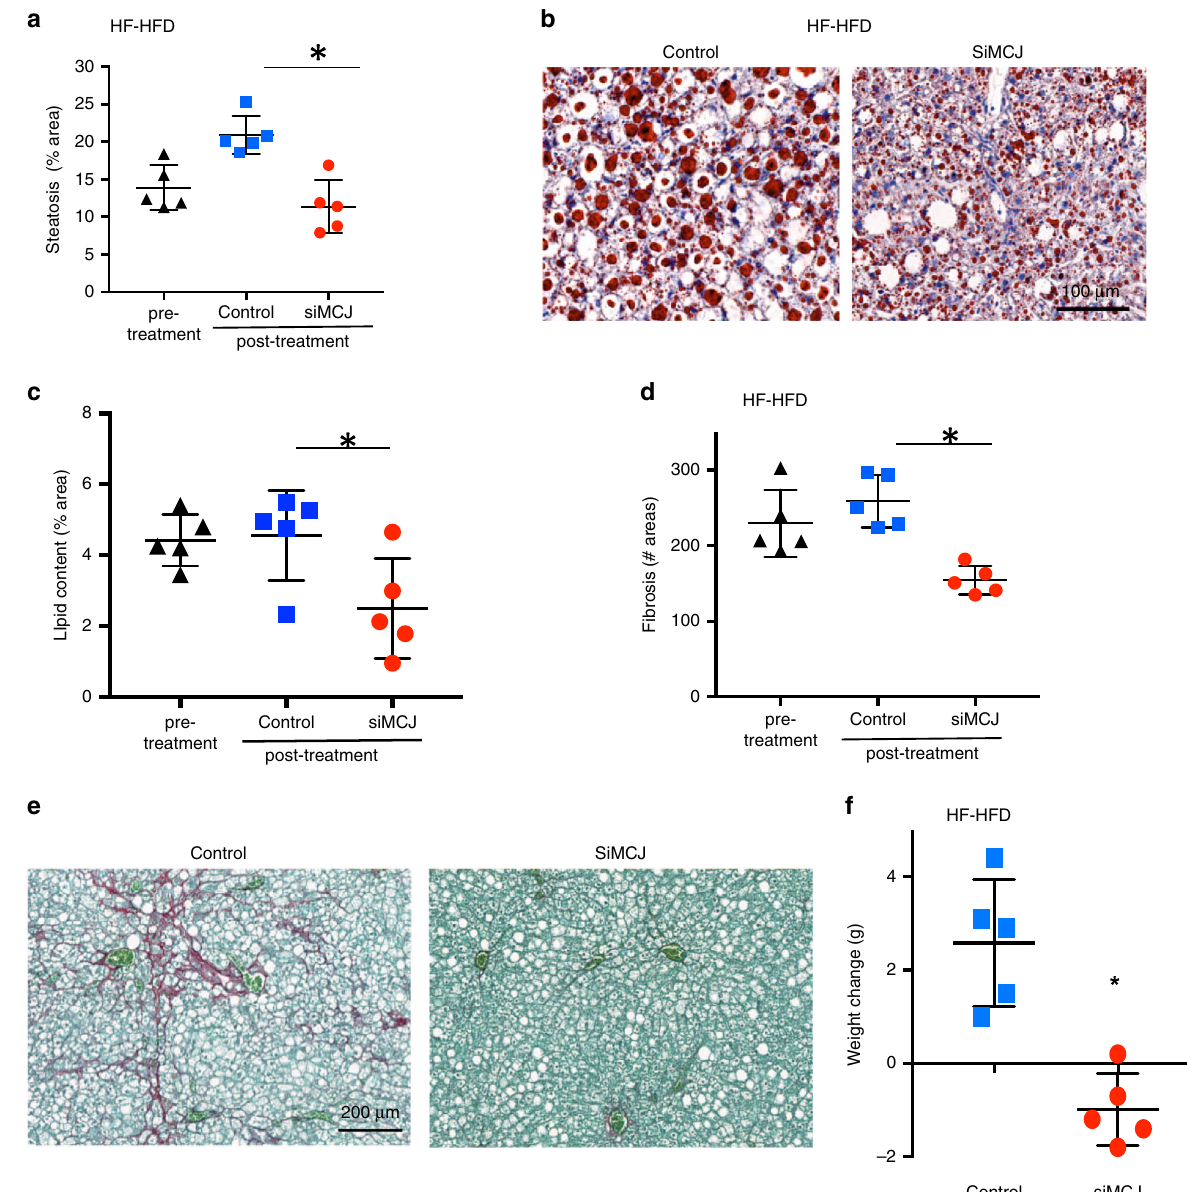
Fig. 4 siMCJ treatment decreases liver steatosis, fi brosis and weight gain in a NASH model with metabolic disorders. Mice were placed on a high-fat, high-fructose diet (HF-HFD) for the duration of the study. Treatment with Invivofectamine-formulated siMCJ ( n = 5) or PBS ( n = 5) started after 4 months on HF-HFD (pre-treatment) and was provided weekly for a total of 5 weeks. Tissues were harvest 1 week after the last treatment. a Quanti fi cation of liver steatosis in H&E staining histological sections. b Representative images of liver lipids by Oil Red O staining. c Quanti fi cation of lipids from Oil Red O stained-liver sections. d Number of fi brotic areas per histological section of the liver as determined by Picro Sirius Red staining. e Representative images of Picro Sirius Red-stained liver sections. f Weight change after 6 weeks of treatment. * p < 0.05 siMCJ-treated compared with PBS control by one-way ANOVA or Student´s t test analysis. Error bars show standard deviation (SD) in all panels. Source data are provided as a Source Data fi